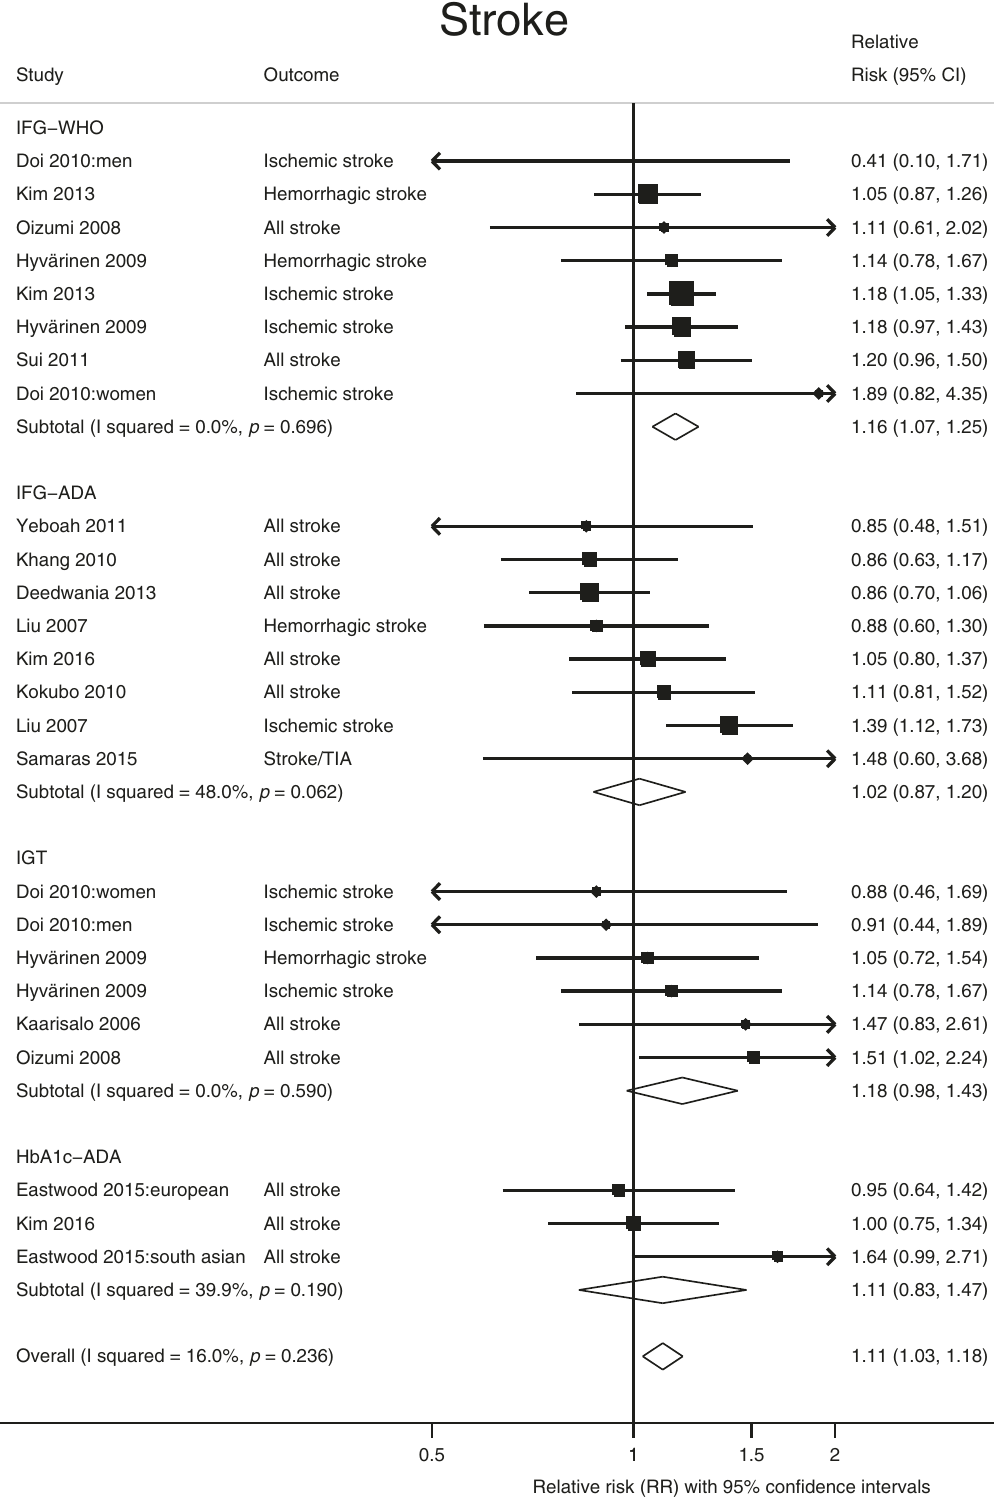
Fig. 3 Meta-analysis of the association between prediabetes and stroke. The square and diamond shapes represent effect size (relative risk estimates), while the horizontal bars represent the 95% con fi dence intervals. A total of 14 studies are included. All P values are two-sided. Source data are provided as Source Data fi